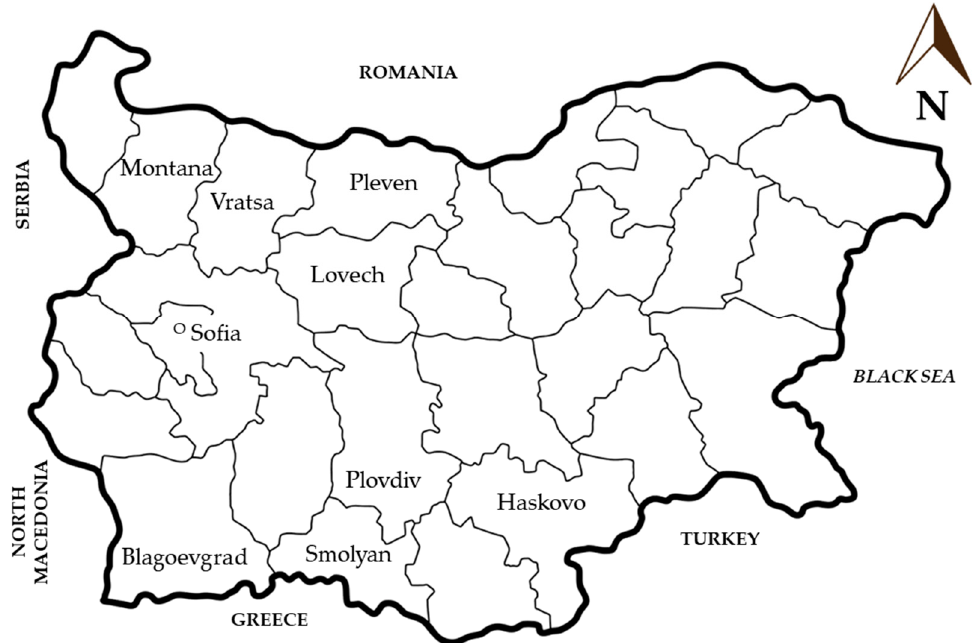
Figure 1. Map of the studied provinces.